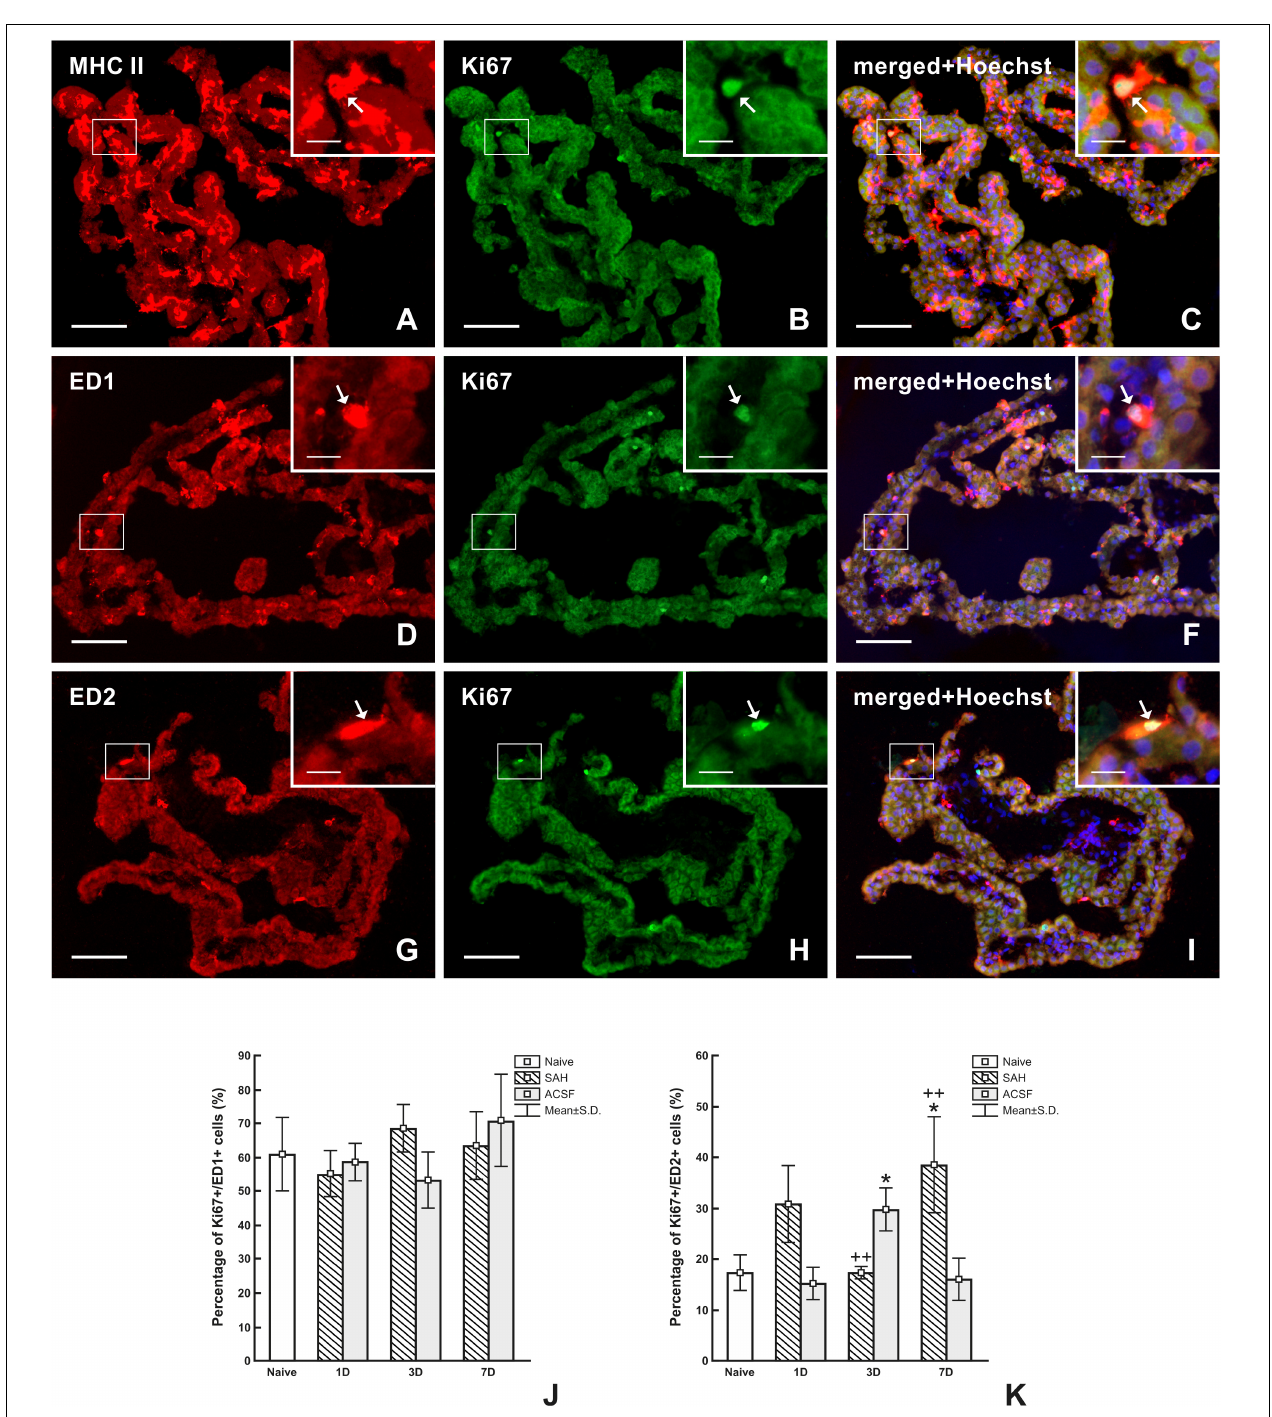
FIGURE 8 | Representative images of double immunostaining to detect MHC II + , ED1 + , and ED2 + macrophages as well as Ki67 + cells in the CP 7 days after SAH. Double immunostaining for MHC II and Ki-67 (A–C) showed that all proliferating cells are antigen presenting cells (arrows) . Simultaneous reaction for ED1 and Ki67 (D–F) proved that most proliferating cells are activated macrophages (arrows) . Double immunostaining reaction for ED2 and Ki-67 (G–I) showed that approximately one-third of proliferating cells are resident macrophages (arrows) . Merged figures (C,F,I) include a merge with Hoechst-stained nuclei. Scale bars – main images 80 µ m; insets 20 µ m. Percentage of ED1 + /Ki-67 + cells (J) and ED2 + /Ki67 + cells (K) in the CP of naïve, SAH and ACSF rats at 1, 3, and 7 days after operation. *Indicates a significant difference when compared to CP from naïve rats ( p < 0.05). ++ Indicates a significant difference when compared to CP from control rats ( p <